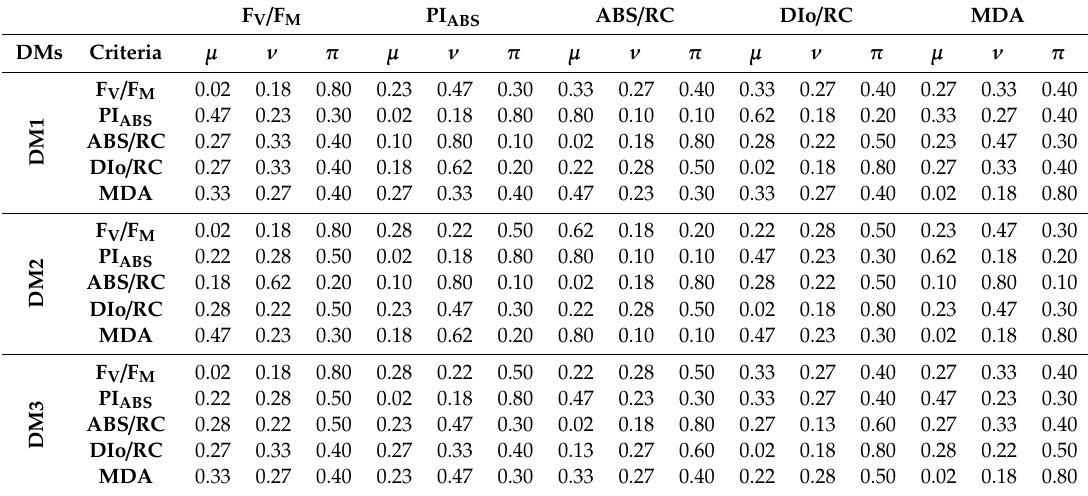
Table 7. Pairwise comparison matrices with intuitionistic fuzzy values for criteria of cold subcategories.